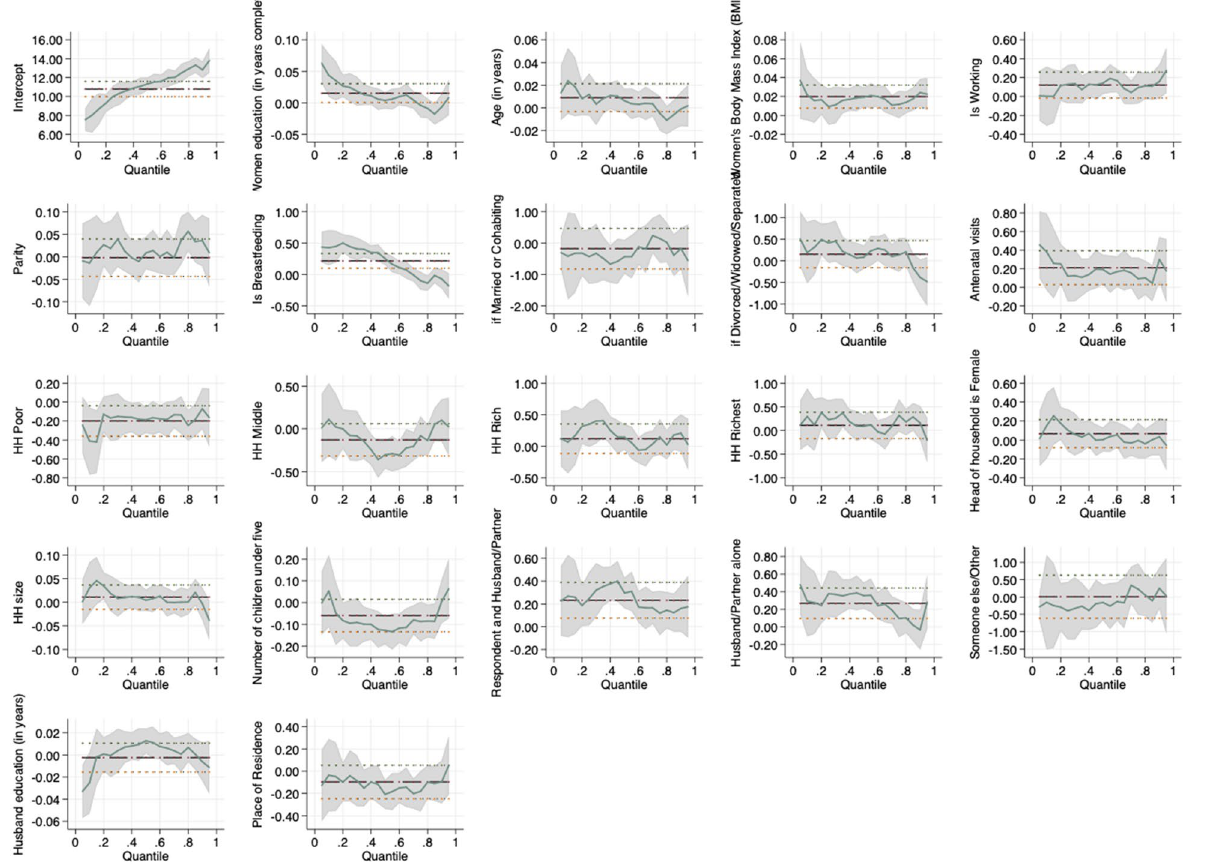
Figure 1. Pictorial presentation of the effects of socio-demographic factors on maternal Hb concentration in